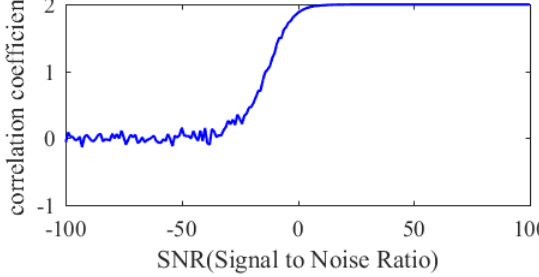
Figure 12. the relationship between the output Euclide distance and signal to noise ratio (SNR).